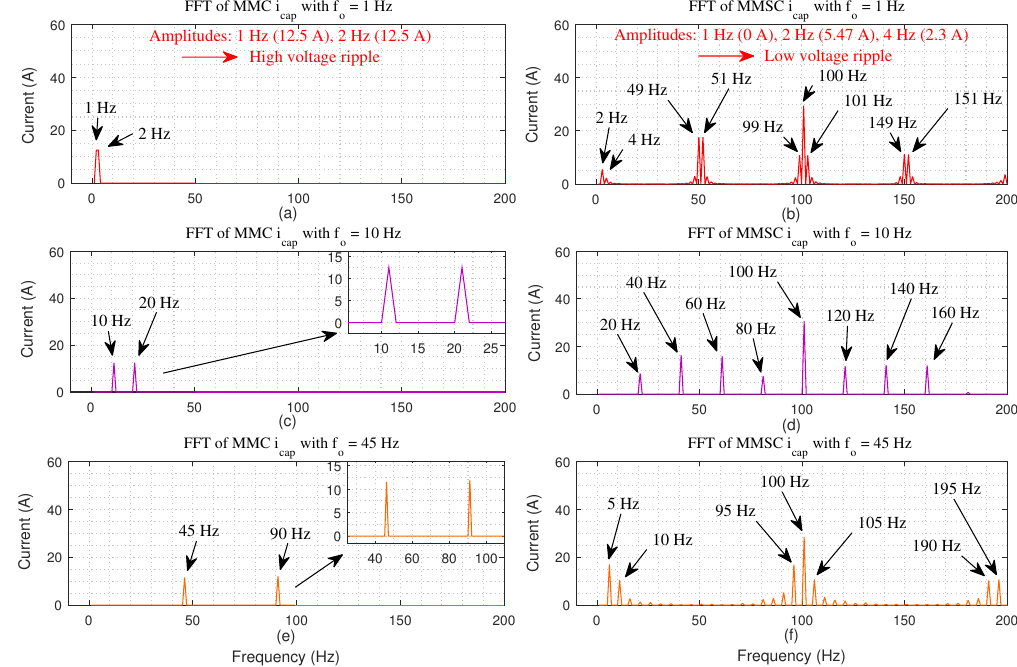
Figure 3. ( a , c , e ) show the fast Fourier transform (FFT) of the MMC submodule-capacitor current ( i cap ) for the cases in which f o = 1,10 and 45 Hz, respectively. ( b , d , f ) show the FFT of the MMSC submodule-capacitor current ( i cap ) for the cases in which f o = 1,10 and 45 Hz,